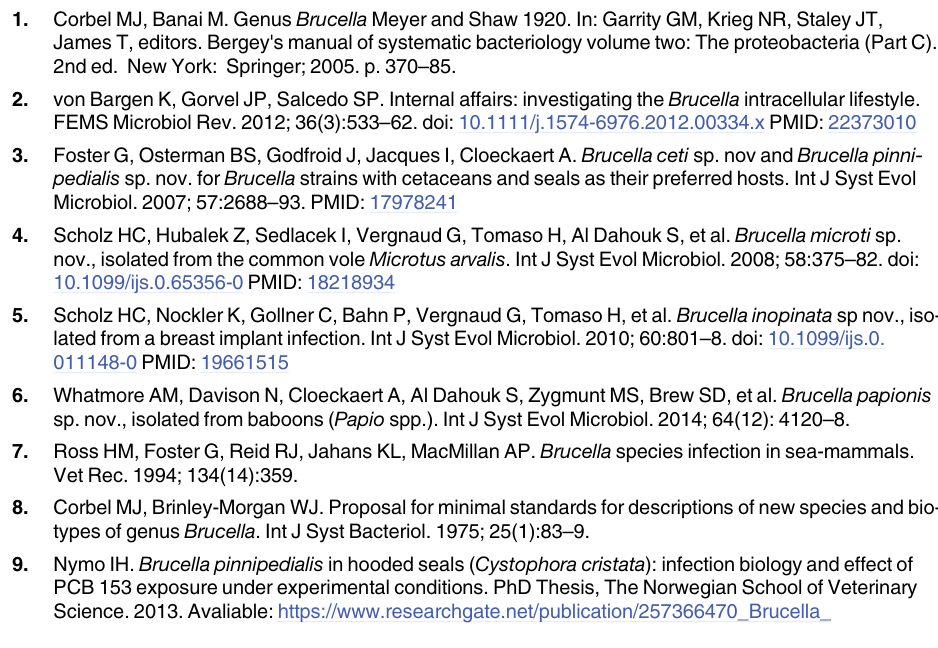
the same HK brucellae, or left unstimulated. As controls, splenocytes from infected and unin- fected mice were stimulated with LPS from Escherichia coli . The experiments were repeated twice. The results are presented as mean + one standard error of the mean. (cid:1)(cid:1)(cid:1) = p < 0.001, (cid:1)(cid:1) = p < 0.01, (cid:1) = p < 0.05. S1 Table. Level of statistical difference between organ weights in uninfected and infected mice. Level of statistical difference between spleen and liver weights in uninfected and infected BALB/c mice after intraperitoneal (ip) inoculation of 10 5 colony forming units (CFU) of B . suis 1330, B. pinnipedialis 12890 or B . ceti 12891. Uninfected mice received sterile phosphate buff- ered saline ip. Four or five mice were euthanized per lot at day 3, 7, 14, 21, 35, 56 and 84 post infection (day 56 and 84; only B . ceti 12891 and B . suis 1330). Infected mice were compared to uninfected mice and (cid:1)(cid:1)(cid:1) = p < 0.001, (cid:1)(cid:1) = p < 0.01, (cid:1) = p < 0.05, ns = not significant, X = not